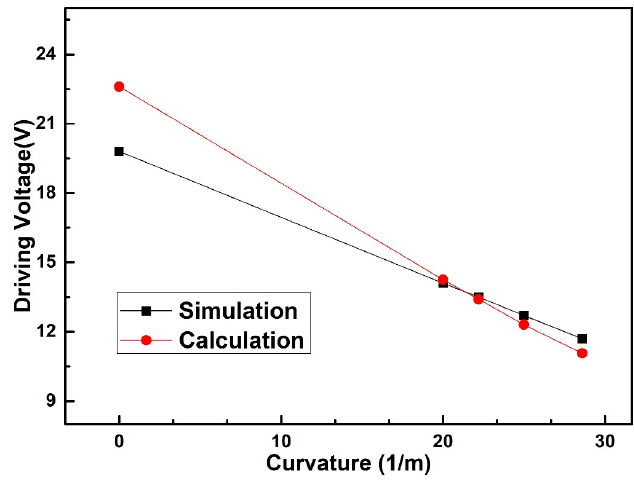
Figure 4. Simulated driving voltage of the spring-like double-clamped beam switch with different substrate curvatures.